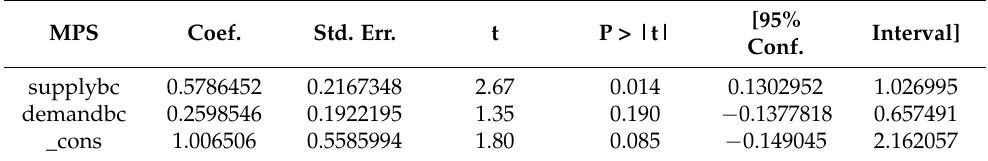
Table 5. Regression analysis after onset of COVID-19